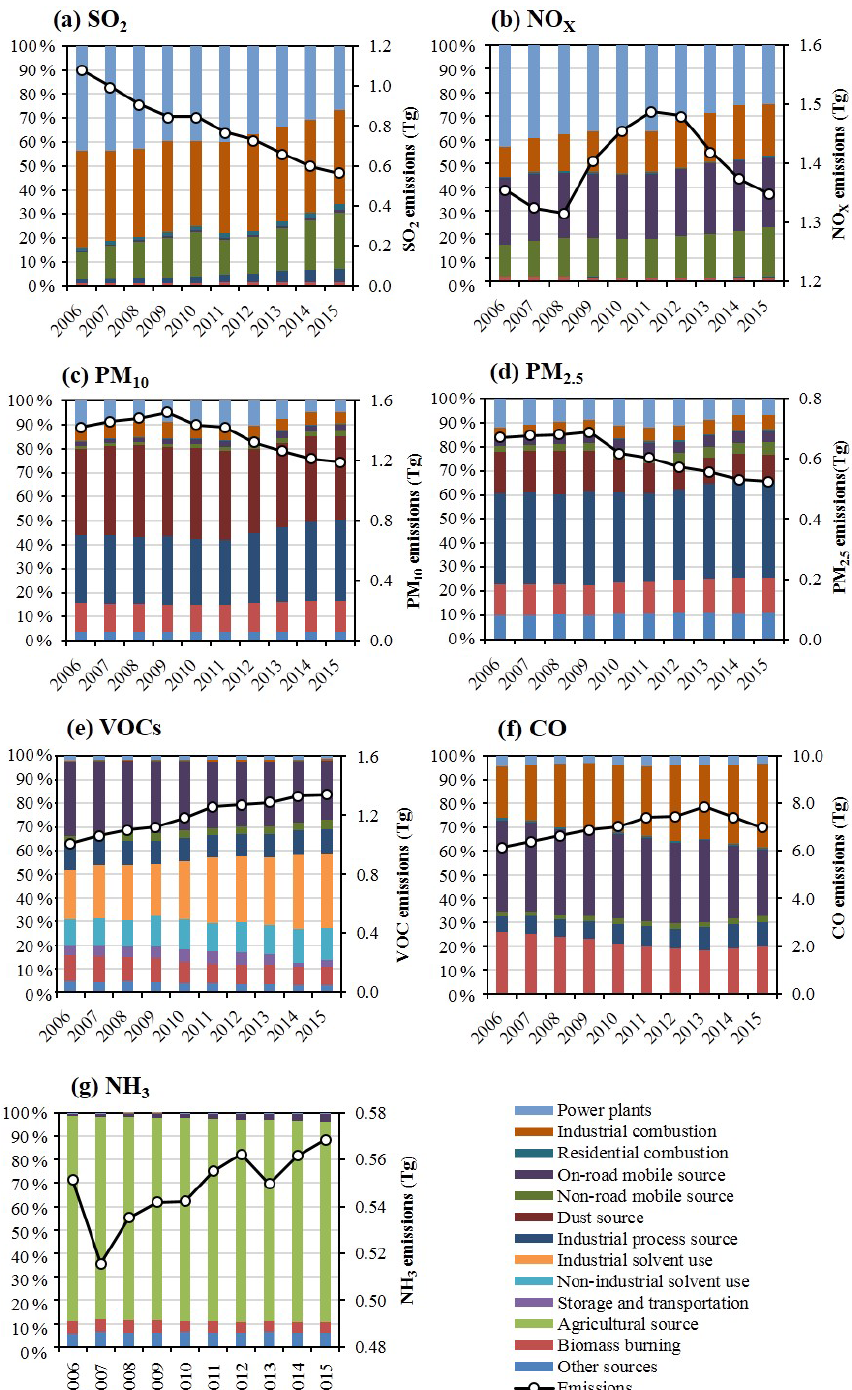
Figure 5. Source emission evolutions in Guangdong Province for (a) SO 2 , (b) NO x , (c) PM 10 , (d) PM 2 . 5 , (e) VOCs, (f) CO, and (g) NH 3 from 2006 to 2015. The stacked column graphs show the emission contributions by source category and year (left axis). The point plots show the total annual emissions in Guangdong Province (right